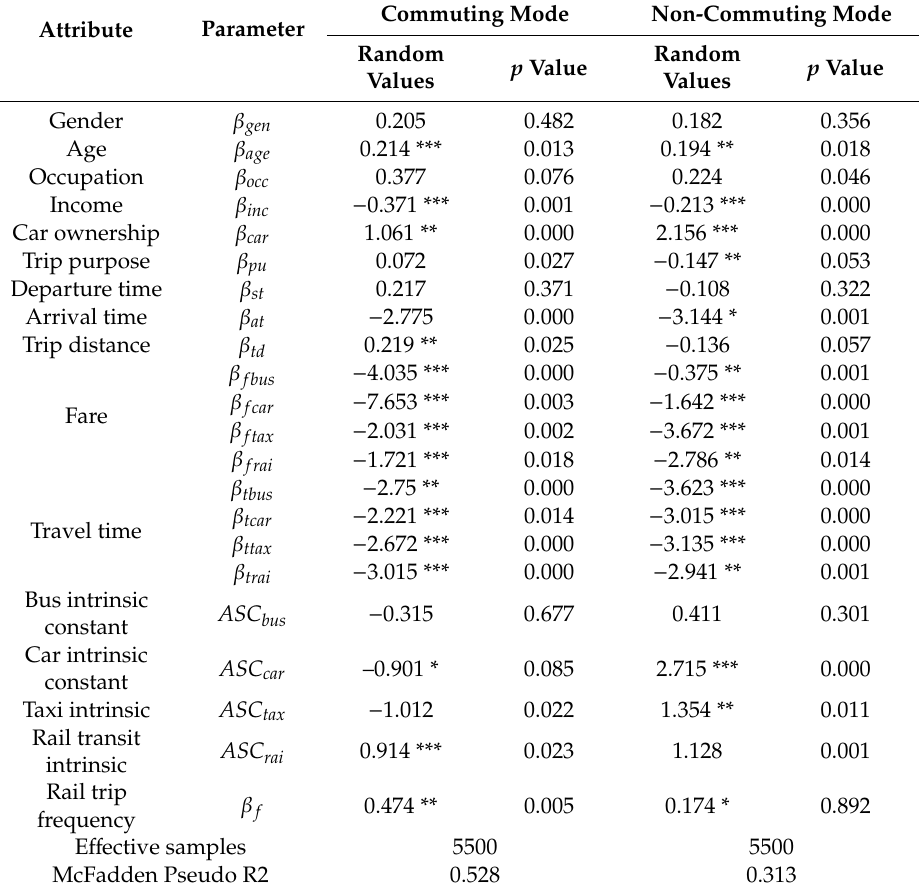
Table 3. Choice of model calibration results based on the Mixed Logit